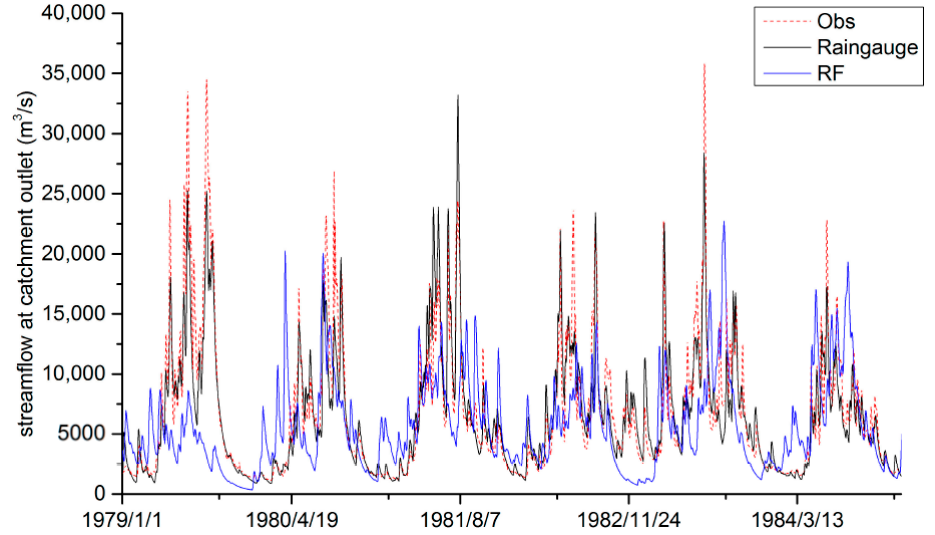
Figure 7. Comparison of flow simulations in the XAJ model driven by historical rainfall from climate models and rain gauge measurements.